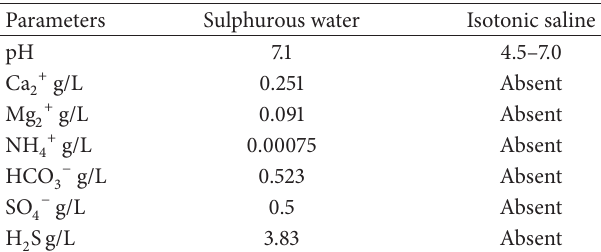
Table 1: Physical and chemical characteristics of sulphurous water and isotonic saline.